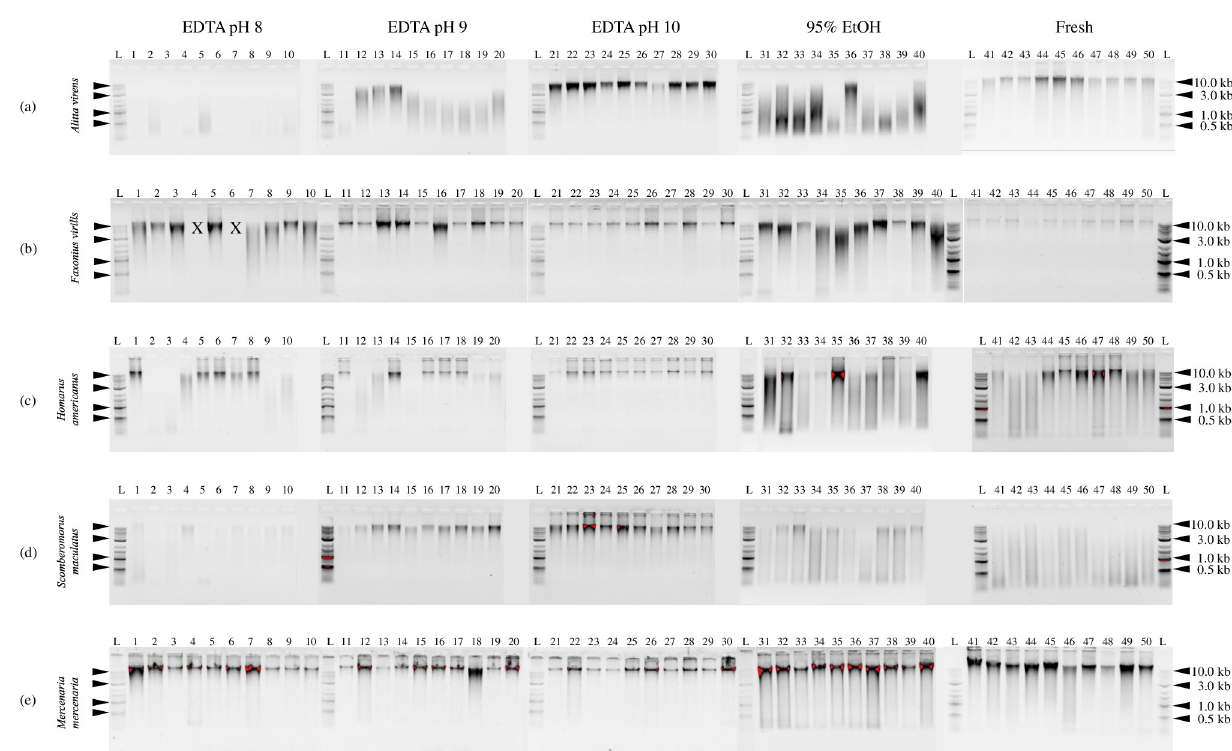
Fig 4. Visualization of DNA extracts by gel electrophoresis. DNA was extracted from (a) Alitta virens , (b) Faxonius virilis , (c) Homarus americanus , (d) Scomberomorus maculatus , and (e) Mercenaria mercenaria tissues after storage at room temperature for 12 months in 0.25 M EDTA pH 8 (lanes 1–10), 0.25 M EDTA pH 9 (lanes 11–20), 0.25 M EDTA pH 10 (lanes 21–30), and 95% ethanol (lanes 31–40). Fresh tissue extracts are shown in lanes 41–50. Lanes marked with an L contain 0.33 μ L or 0.66 μ L Quick Load Purple 1 kb Plus DNA Ladder (100 μ g/mL; New England Biolabs; Ipswich, MA). Lanes marked with an X indicate samples that were not recovered. Specimens are presented in the same order across all treatments.